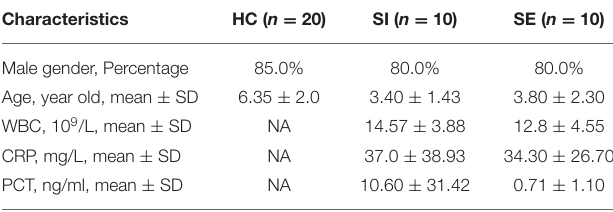
TABLE 1 | Summary of clinical